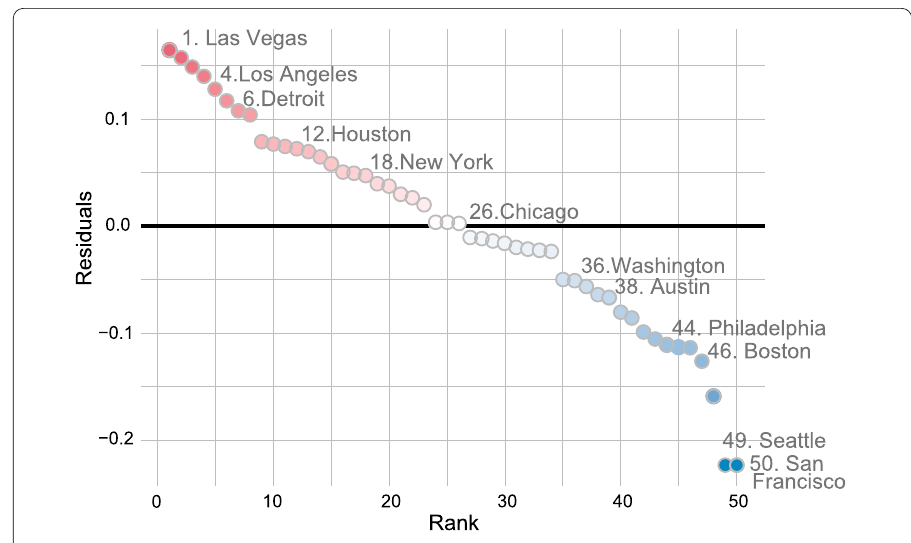
Figure 5 Rankingofcitiesbydeviationsofspatialdistribution . Cities are ranked according to the value of residual from the regression line, expressing the scaling relation of spatial distribution. Cities above the line showing positive deviations (e.g., Las Vegas, Los Angeles) have a more uneven distribution of amenities with respect to their population distribution. Cities below the line (e.g., San Francisco, Boston) show a negative deviation, meaning that amenities can be found in more different areas of the city